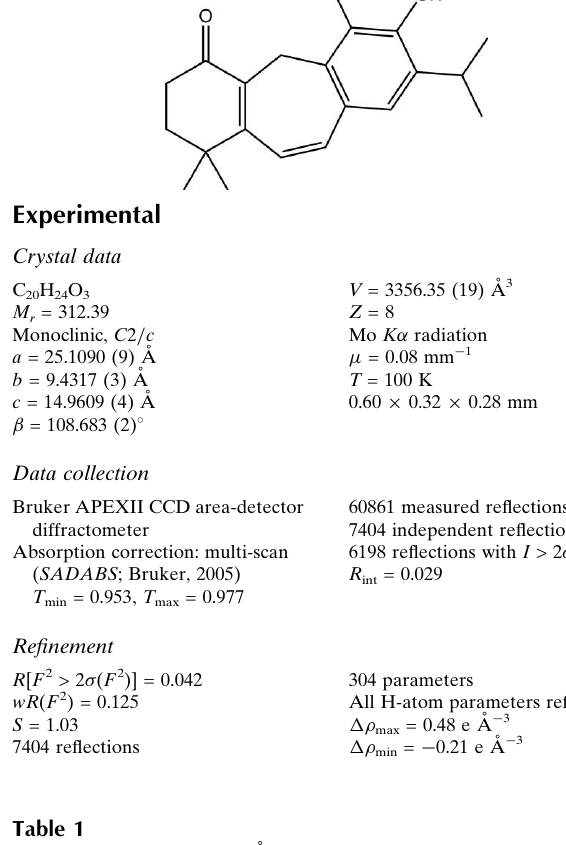
Hydrogen-bond geometry (A˚ , (cid:3)